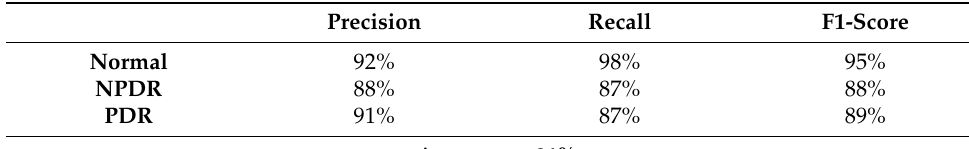
Table 8. Performance metrics of proposed